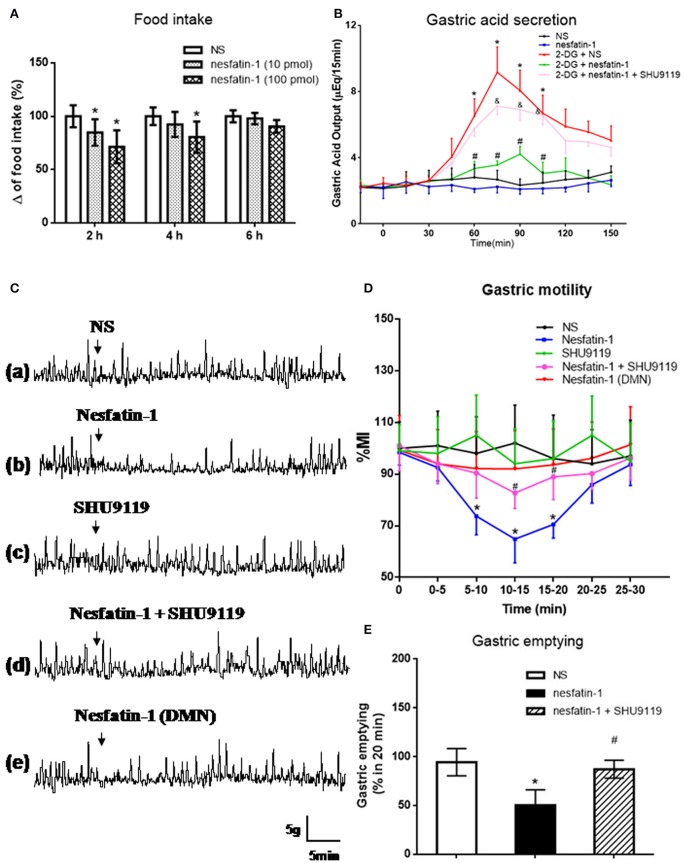
Effect of VMH injection of nesfatin-1 on food intake and gastric function. (A) VMH injection of nesfatin-1 decreased food intake during night period, *P < 0.05 vs. NS. (B) Nesfatin-1 attenuated gastric acid secretion induced by 2-deoxy-D-glucose, *P < 0.05 vs. NS, #P < 0.05 vs. 2-DG + NS,&P < 0.05 vs. 2-DG + nesfatin-1; (C,D) Gastric motility was inhibited by nesfatin-1, *P < 0.05 vs. NS, #P < 0.05 vs. Nesfatin-1. (E) Nesfatin-1 delayed gastric emptying of a viscous non-caloric meal in conscious rats.*P < 0.05 vs. NS, #P < 0.05 vs. nesfatin-1.